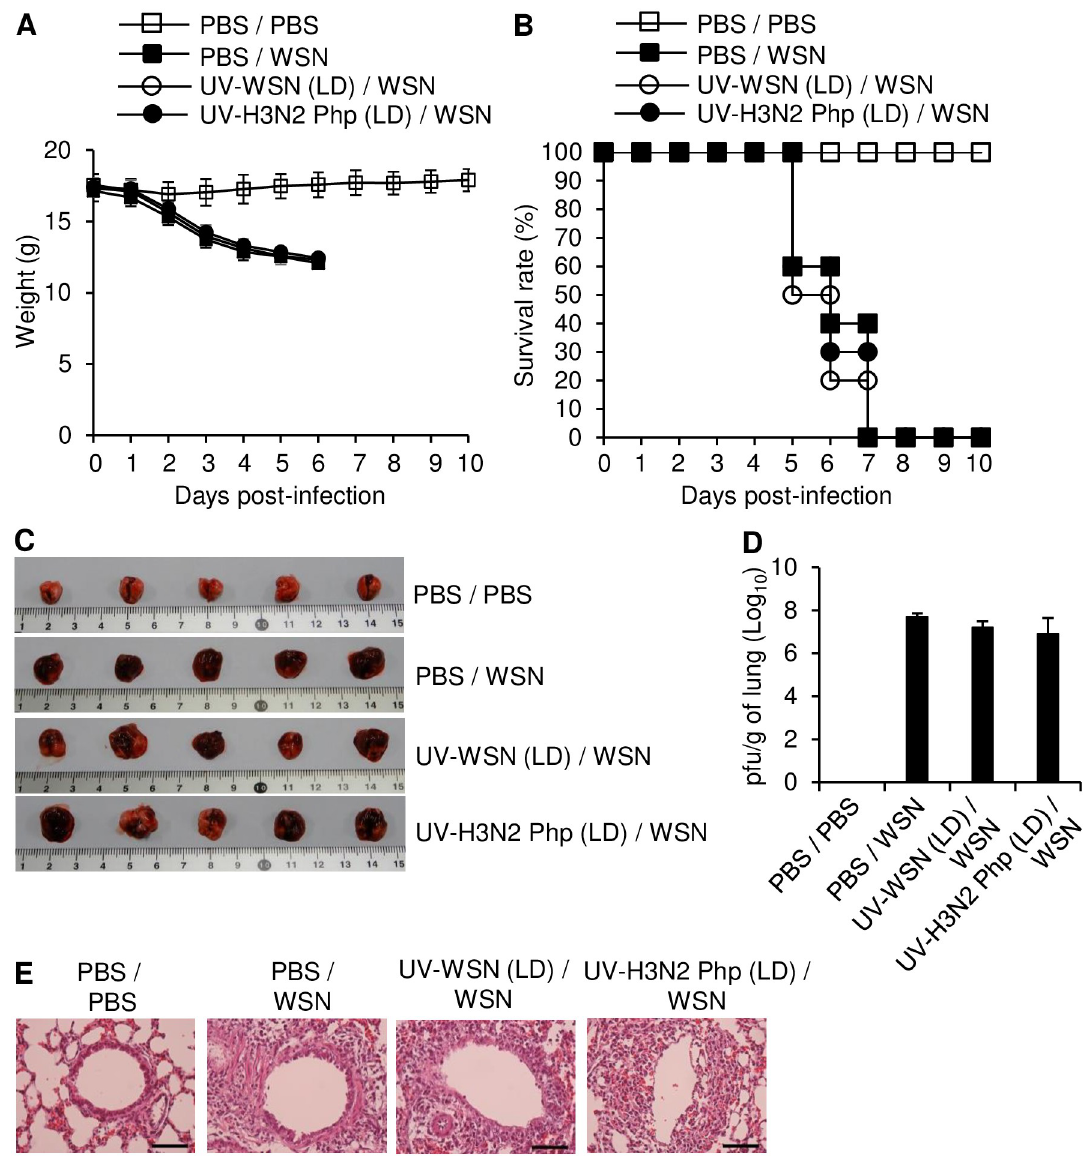
Fig 3. Intramuscular immunization with a low dose of UV-inactivated virus had no protective effect against intranasal challenge with live virus. BALB/c mice were inoculated intramuscularly with 5 × 10 6 pfu of UV-inactivated Influenza A/WSN/1933 (UV-WSN) or UV-inactivated Influenza A/Philippines/2/1982 (UV-H3N2 Php). At day 14 after inoculation, the mice were challenged intranasally with 10 LD 50 of live Influenza A/WSN/1933 (WSN). (A, B) Survival (A) and body weight (B) were evaluated over a 10-day period after the intranasal challenge (n = 10/group). (C–E) Lung tissues and blood were collected 5 days after the intranasal challenge (n = 5/group). (C) Macroscopic features of the lung were examined. (D) Viral titers in lung homogenates were determined by plaque assay. (E) Paraffin-embedded sections of lung tissue were stained with H&E. Scale bars: 25 μ m.